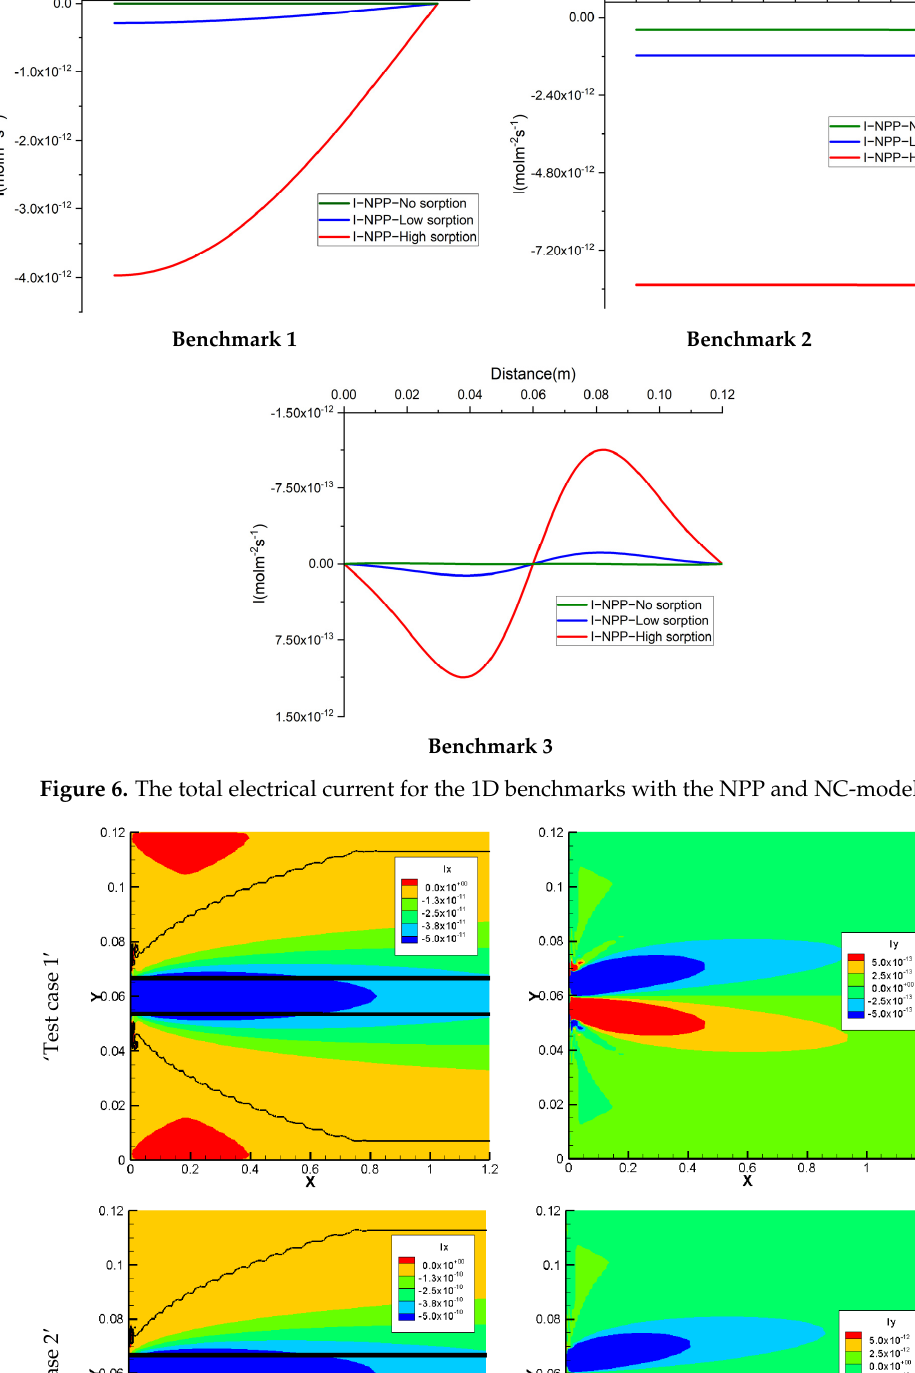
Figure 6. The total electrical current for the 1D benchmarks with the NPP and NC-models.